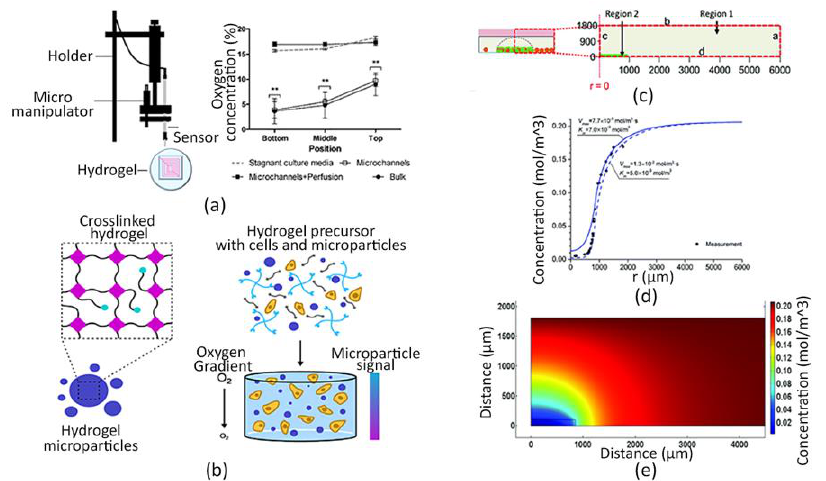
Figure 3. O 2 detection. ( a ) The optical fiber-based sensor set up composed of a micromanipulator and an optical needle microsensor to investigate O 2 concentration within 3D cell-laden hydrogel (left); O 2 levels measured at different depths (bottom, middle position, top) after 24h of bioprinting in the following tested conditions: “Microchannels”, indicating the presence of microchannels within the hydrogel without perfusion; “Microchannels + Perfusion”, indicating the presence of microchannels within the hydrogel with perfusion; “Bulk”, indicating the absence of microchannels within the hydrogel. Stagnant culture media were used as control (right) ** p < 0.01 when compared to culture media [156]. ( b ) Schematic illustration of the 3D millimeter-scale cellularized PEG hydrogel: hydrogel-based microparticles biosensor incorporating O 2 -sensitive fluorescent dyes (left) were encapsulated within cell-seeded PEG hydrogel (right). ( c ) Side-view representation of the cell-free (Region 1) and the cell-laden (Region 2) collagen hydrogel. Polydimethylsiloxane PDMS O 2 sensing microbeads were distributed in the entire polymeric matrix. Dotted lines delimit the computational domain. Boundaries “a” and “d” represent PDMS– and polystyrene–hydrogel interfaces, respectively. Boundary “b” represents cell culture media–air interface. Boundary “c” represents the z-axis at a radial position of 0, in the disk-shaped hydrogel. Regions 1 and 2 represent the cell-free hydrogel plus cell culture media, and cell-laden hydrogel regions, respectively. ( d ) Experimental data of O 2 concentrations and their best fitting within the 3D hydrogel versus the distance from the center of the hydrogel. ( e ) Spatial map of the simulated O 2 concentration within the selected computational domain. ( b ) Adapted and reprinted with permission from [153]. Copyright (2019) American Chemical Society; ( c – e ) Reproduced from Ref. [169] with permission from the Royal Society of Chemistry.